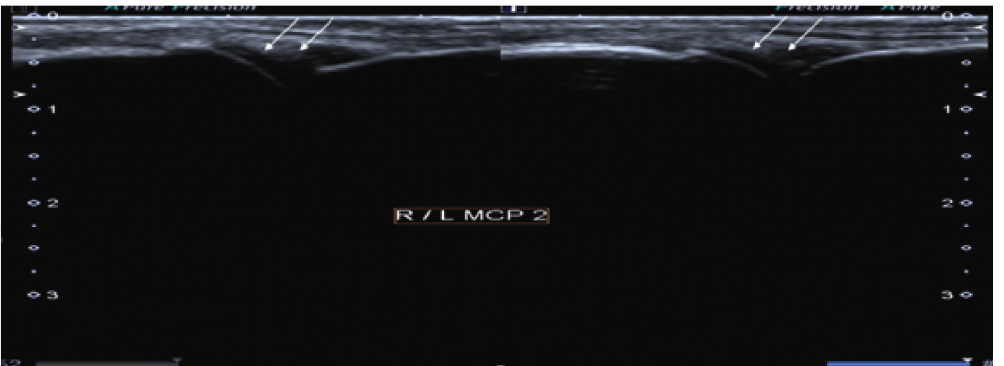
Figure 1: Grayscale images of right and left 2 nd metacarpophalangeal joint demonstrating moderate synovial thickening (white arrows). The findings are consistent with Grade 2